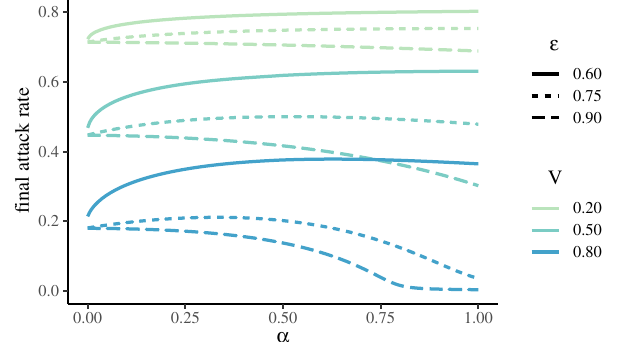
Fig. 4 Final attack rate for different values of vaccine ef fi cacy and coverage. Final attack rate as a function of the mixing parameter, α , for different combinations of vaccine ef fi cacy, ε , and coverage, V , given a basic reproduction number R 0 = 2.5. As a complement to Fig. 3, this plot illustrates how all three dynamical regimes can be also explored by varying V or ε , or